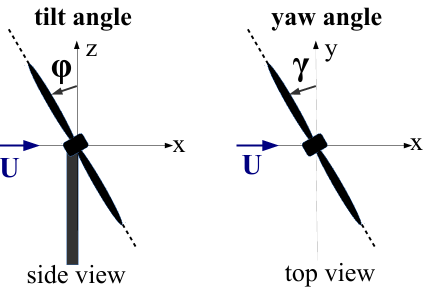
Figure 1. Definition of the positive rotor tilt and yaw angles ϕ and γ used in the present study. Positive tilt angles can be obtained for downwind-oriented rotors to avoid blade–tower